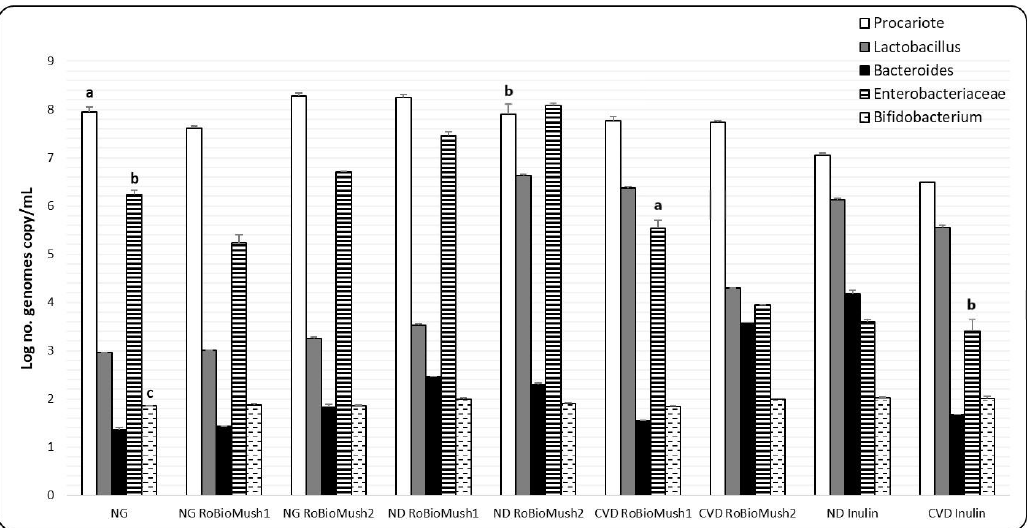
Figure 2. Number of microorganisms in the analyzed samples. Different letters mean significant statistical differences ( P ≤ 0.05).